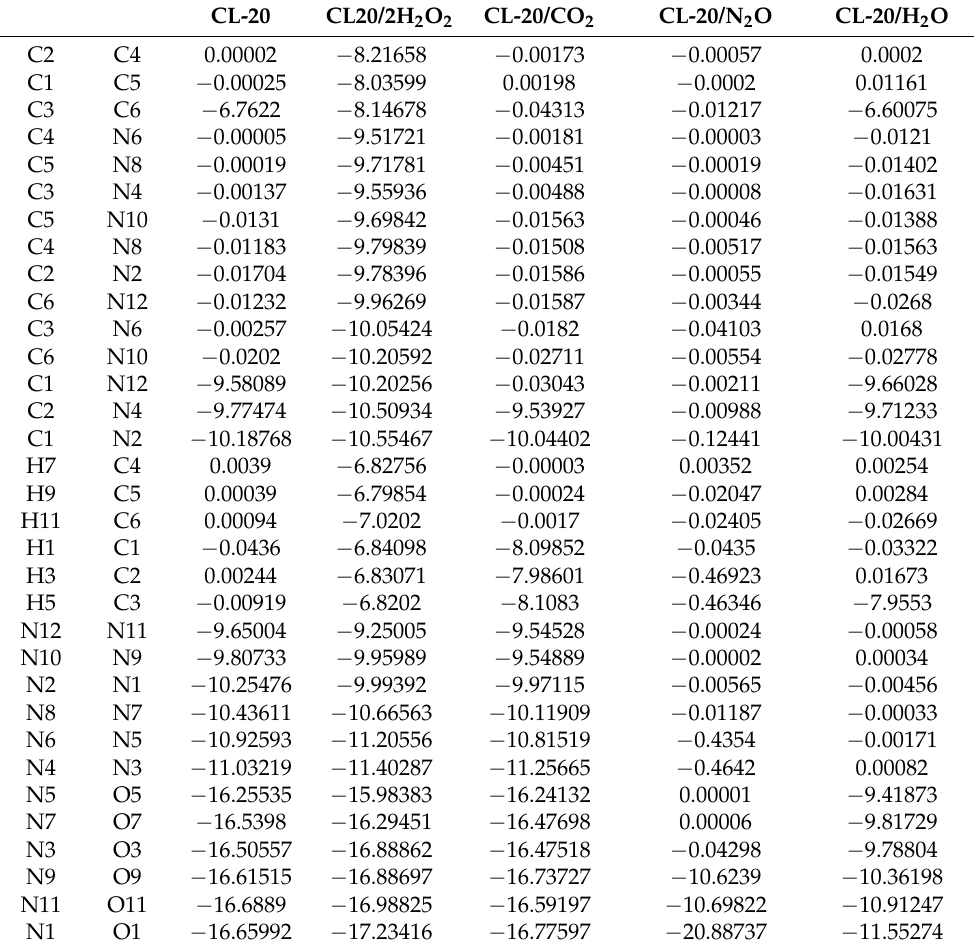
Table 3. The ICOHP between two atoms for CL-20 and its